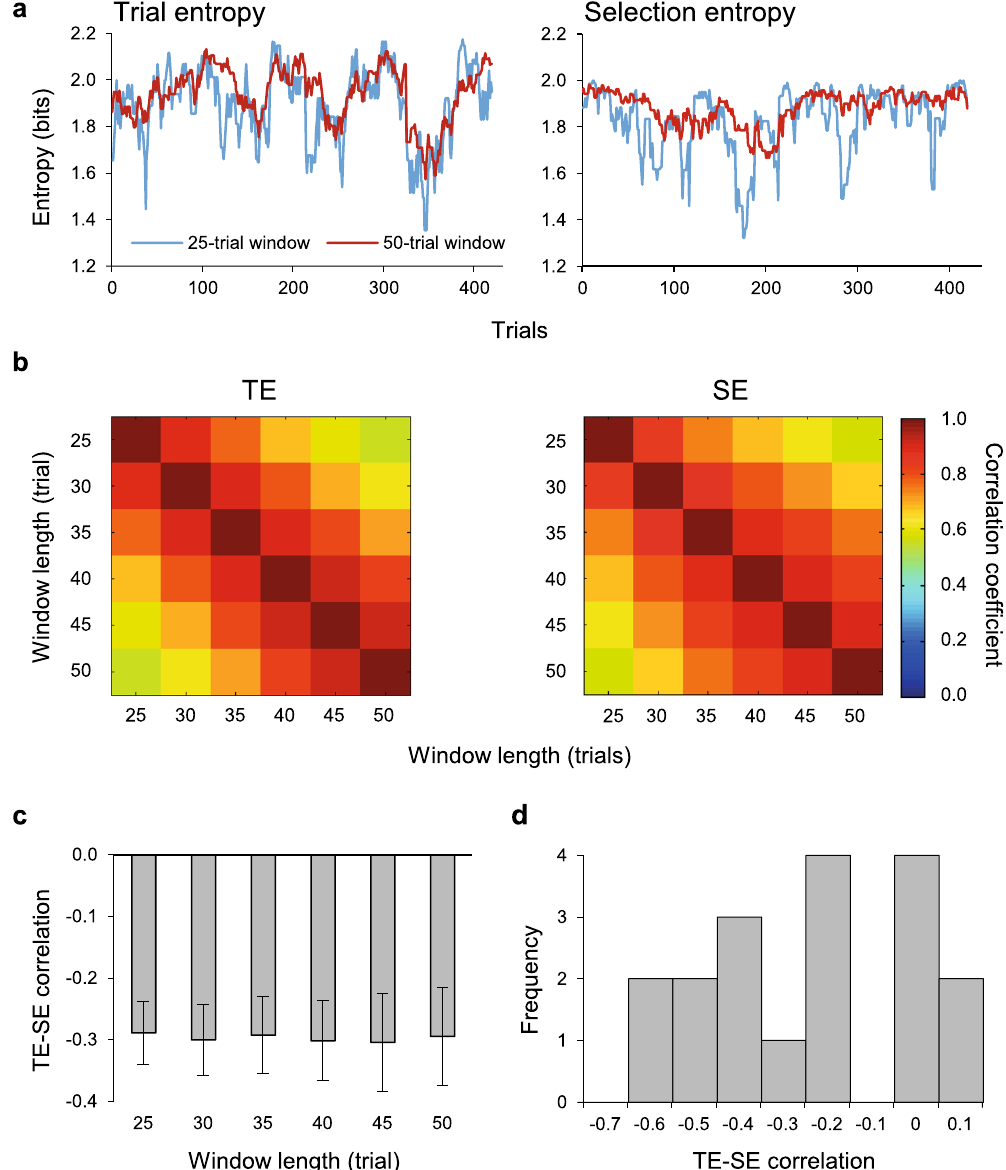
Figure 2. Entropy measures. ( a ) Trial entropy (TE, left) and selection entropy (SE, right) for a single participant. The blue lines are entropy measures using the 25-trial sliding-window and the red lines are the 50-trial entropy measures. ( b ) Correlation of the different sliding windows for TE (left) and SE (right), averaged across all participants. All correlations were significant (p < 0.003, even with conservative Bonferroni correction, noting that the entropy measures are not independent tests between sliding windows of different length). ( c ) The mean Fisher transformed correlations between TE and SE with standard error bars. Each correlation was significant. ( d ) A histogram showing frequency of TE-SE correlation across participants for the 25-trial window. Some individuals displayed a strong negative correlation between TE and SE, while others demonstrated a weaker or no